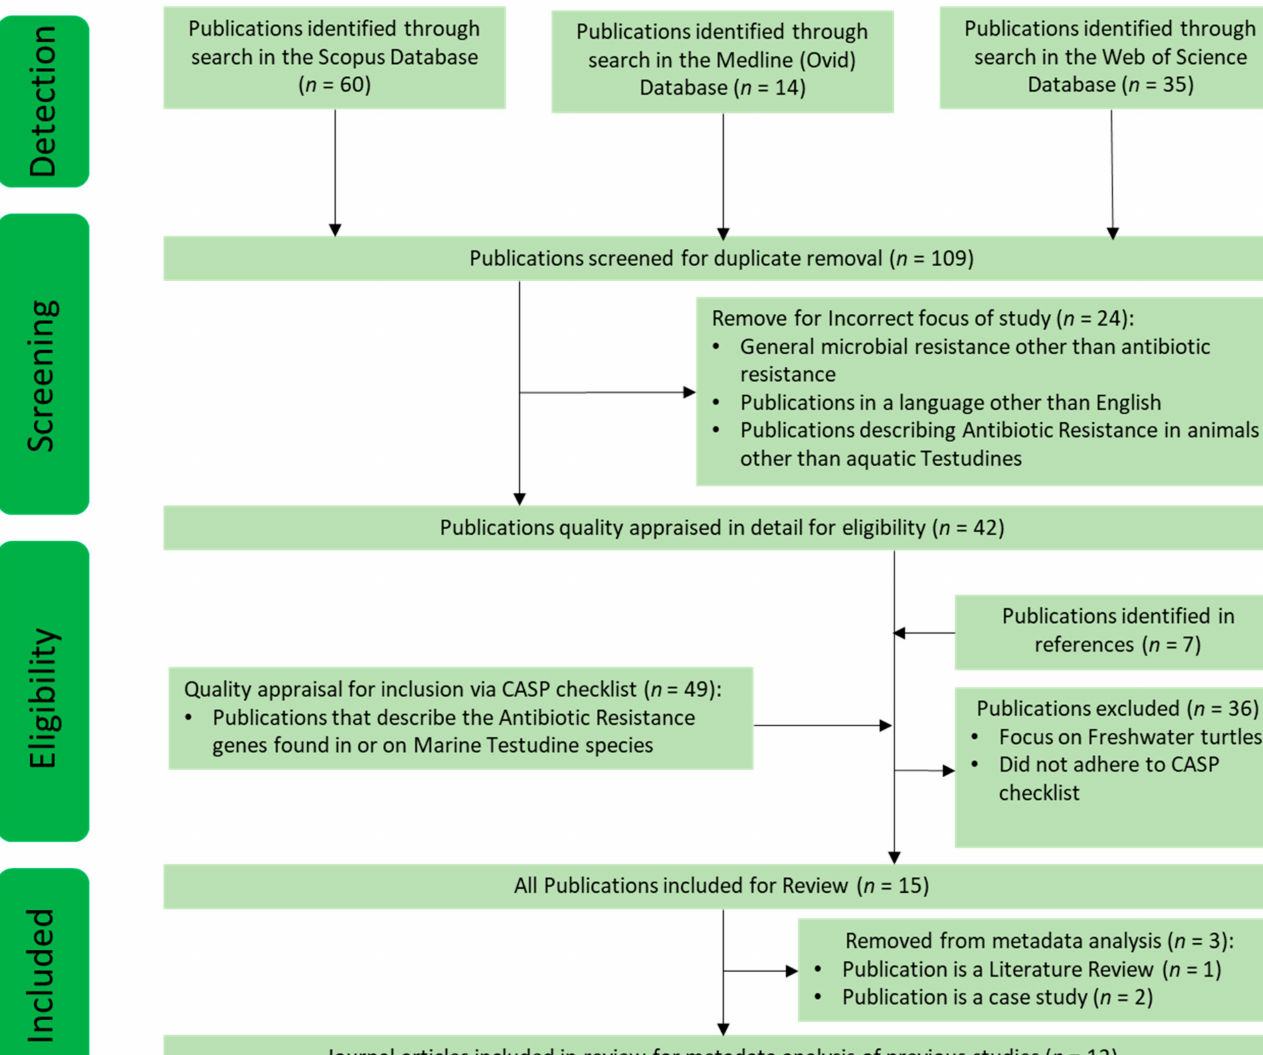
Figure 1. Summarised process for the literature search indicating detection, screening, and eligibility of included publica- tions. Fifteen articles were retained for final analysis, but only 12 of these were direct, original studies on the abundance and effect of ARB in marine turtles. Twelve studies were included for analysis of the